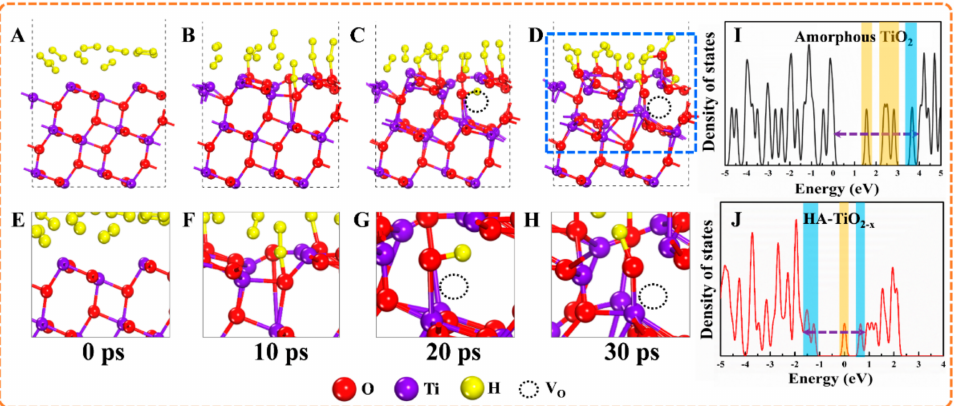
Figure 6. ( A – D ) are the simulated generation process of surface and subsurface O V by density functional theory (DFT), and ( E – H ) are the corresponding enlarged views of the top surface. ( I , J ) are the electrical bandgap structures of amorphous TiO 2 and HA-TiO 2 − x , respectively. To clearly demonstrate the bandgap structures, the schematic illustration was pre- sented in Figure 7.